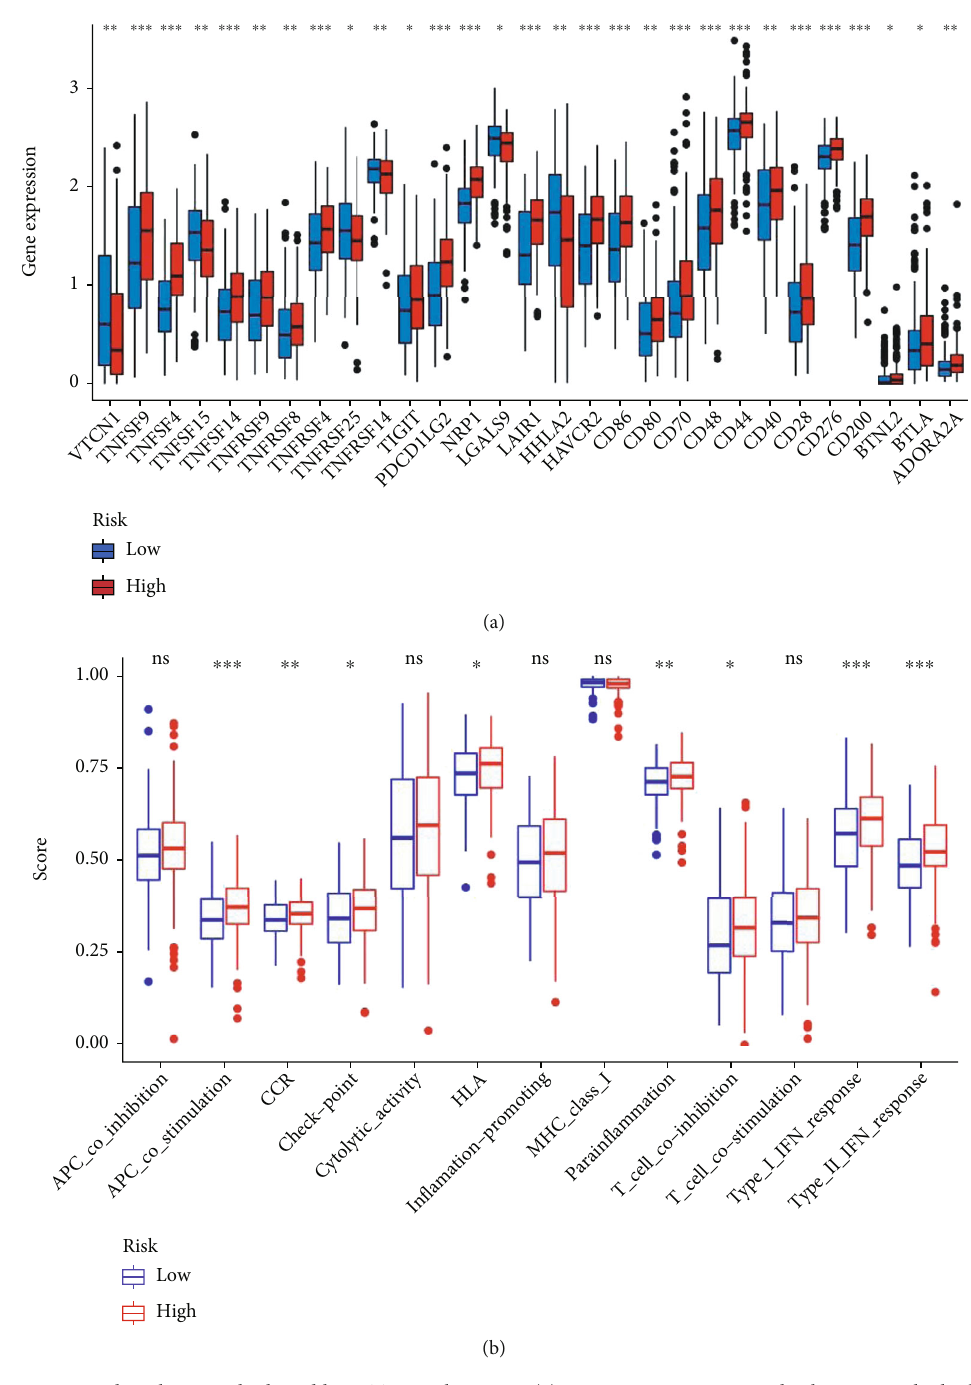
Figure 9: The immune analysis between high and low STAD risk groups. (a) Expression at immune checkpoints in the high and low STAD risk groups. (b) Di ff erential associations between immune cell subsets and related